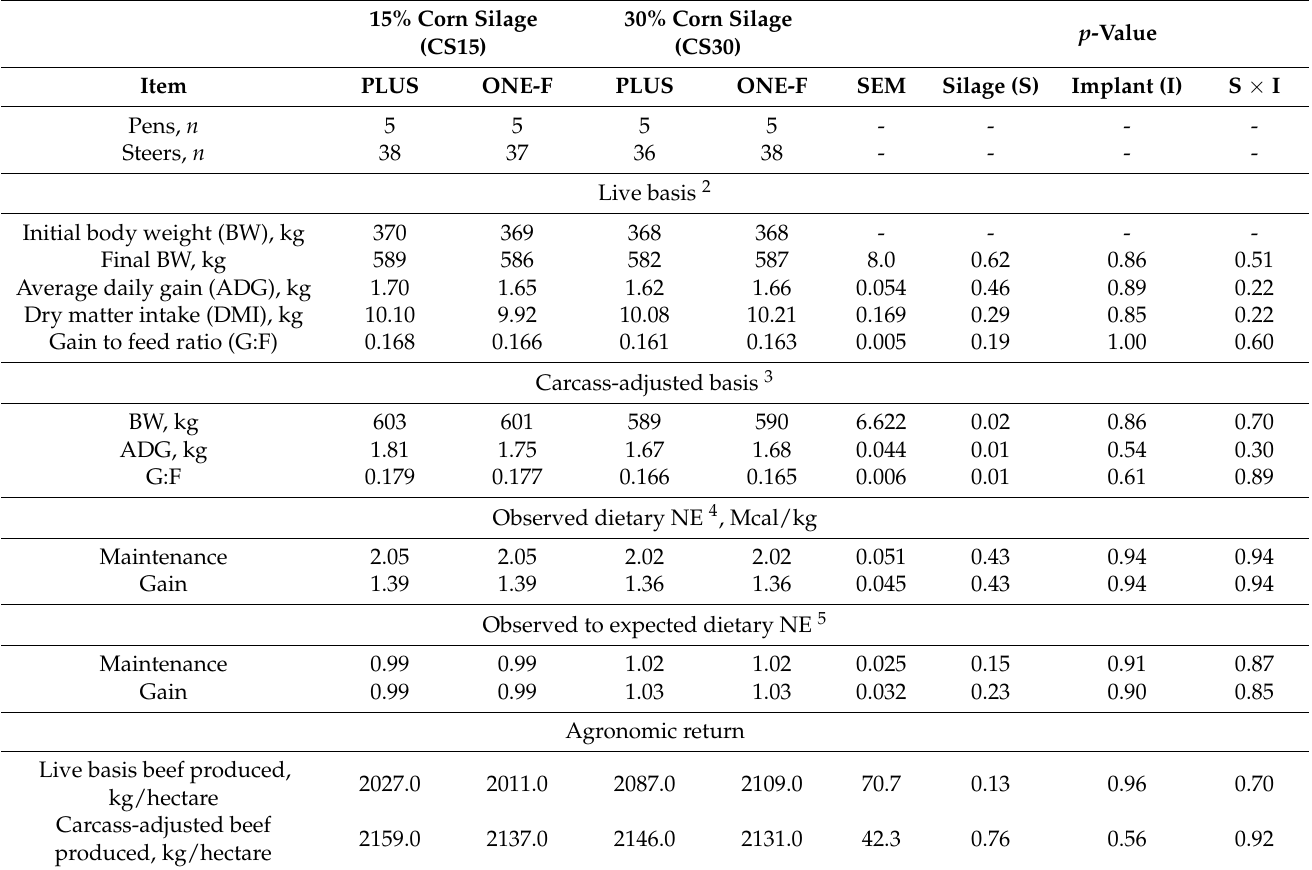
Table 2. Cumulative live (shrunk) and carcass-adjusted (hot carcass weight (HCW)/0.63) growth performance responses and beef production per hectare of cropland in finishing diets containing 15% or 30% (DM basis) corn silage and administration of a non-coated (PLUS) or coated (ONE-F) implant containing 200 mg of trenbolone acetate and 28 mg of estradiol benzoate 1